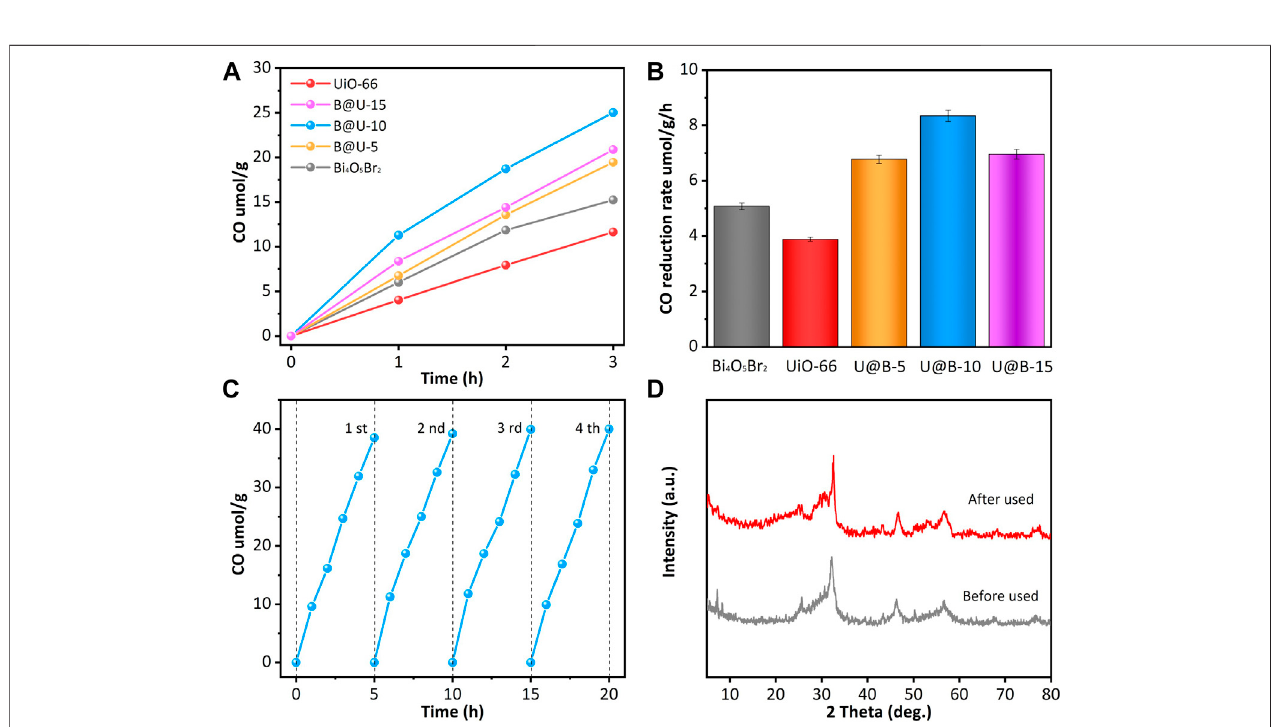
FIGURE 4 | (A) Photocatalytic CO 2 reduction and (B) CO 2 reduction rates of different samples; (C) stability test of U@B-10 and (D) the XRD patterns of U@B-10 before and after cycles.